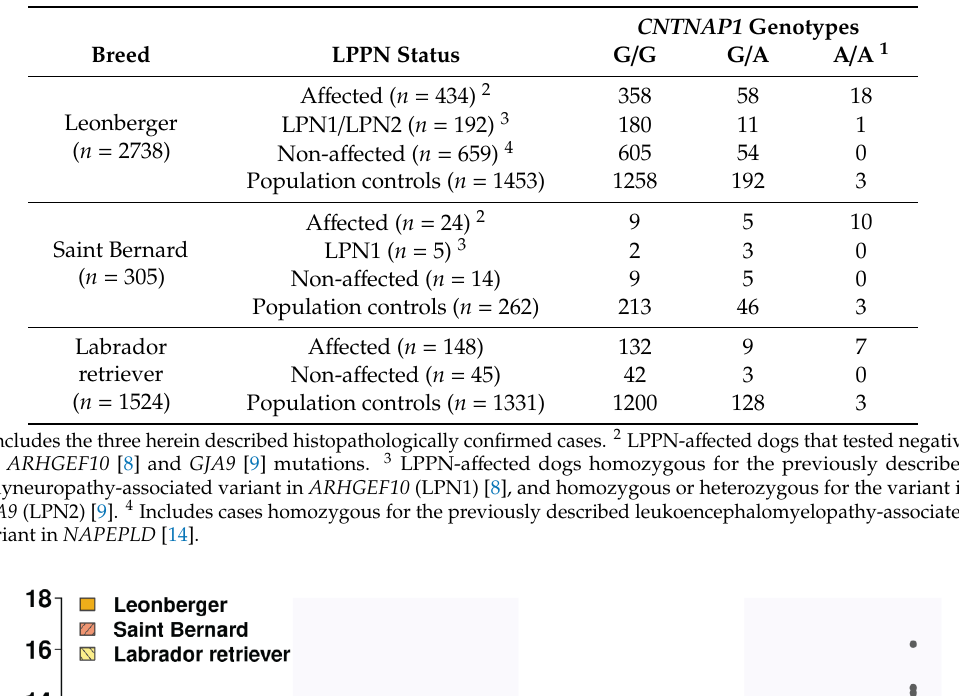
Table 2. Segregation of the CNTNAP1 :c.2810G > A genotypes with laryngeal paralysis and polyneuropathy (LPPN) in three breeds with available health information.